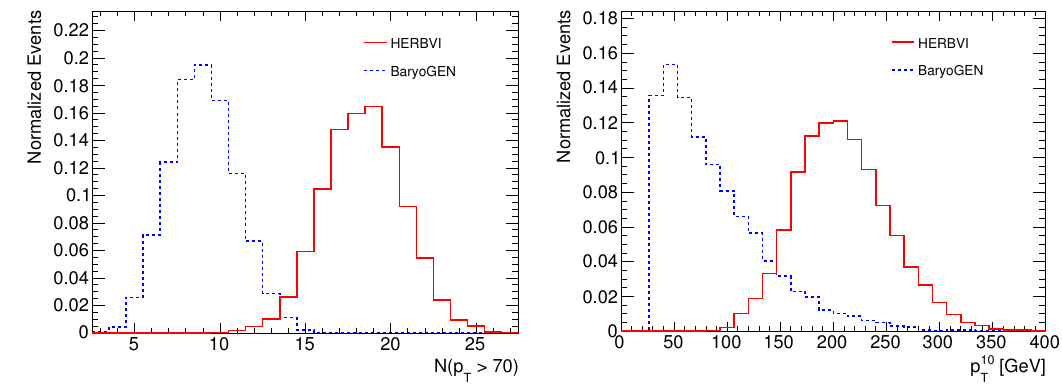
Figure 4 . Left panel: the inclusive multiplicity containing jets, leptons and photons with p T > 70 GeV. Right panel: the transverse momentum distributions of the 10th hardest jet. The red-solid and blue-dashed histograms correspond to HERBVI and BaryoGEN event